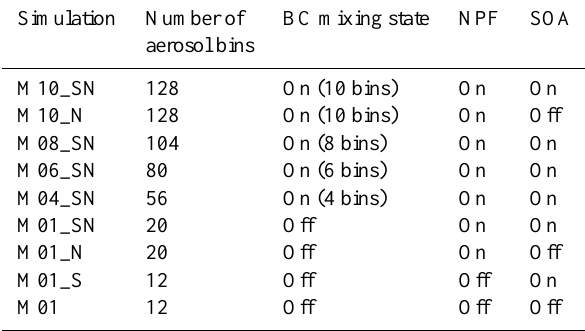
Table 2. List of model